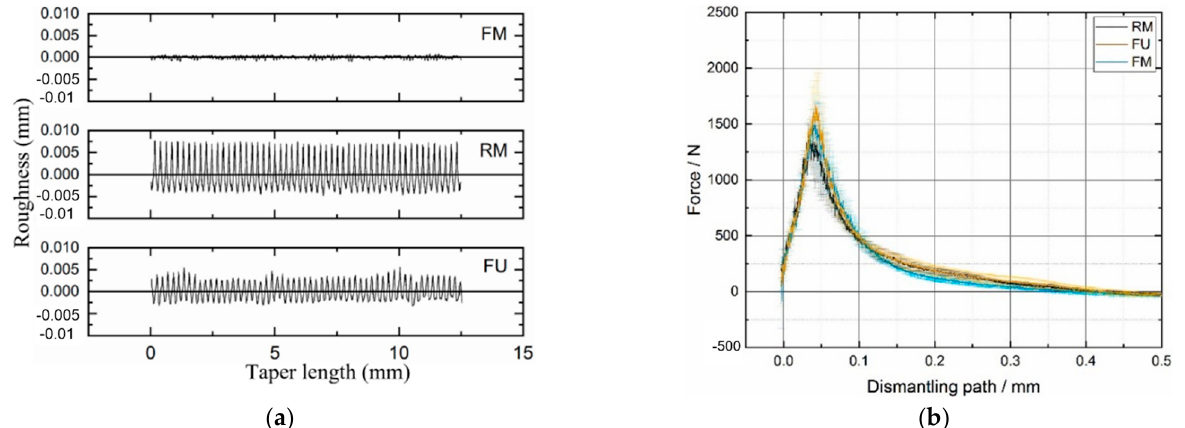
Figure 5. ( a ) Three surface topographies machined on the 12/14 Ti trunnions. ( b ) The dismantling force for the three types of the assembled junctions (Mai et al. [28]).